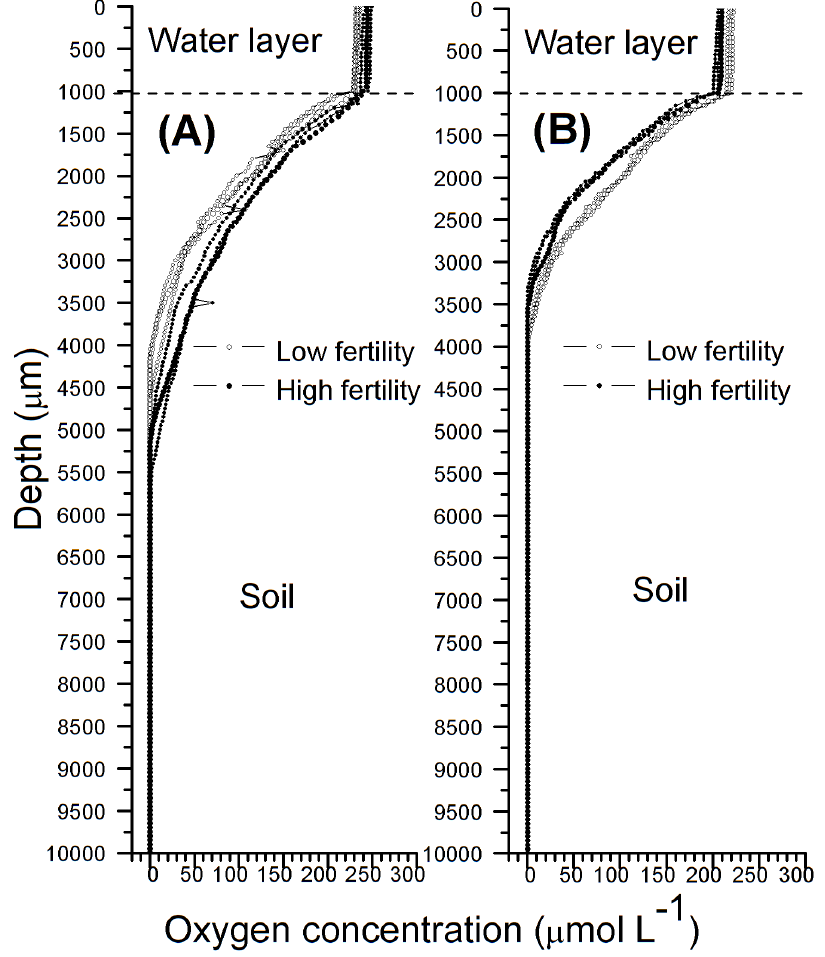
Figure 4. A representative graph showing oxygen profiles of (A) the rhizosphere soil (2 mm away from the root surface) and (B) the control (without rice plants) 50 d after germination in paddy soils with different fertility levels at 20 6 C. The oxygen microelectrode used was 20–30 m m in diameter (OXY25, Unisense, Aarhus, Denmark [31]). Three rhizoboxes for each treatment were used in the in situ measurements, and the oxygen concentration profile was determined in the right and left compartments of each rhizobox. All measurements were conducted in the centre of the range marked by a 2-mm distance from the nylon nets in the low- and high-fertility soils with and without the rice plant treatments. Hence, the measurements were repeated six times in each treatment. Three results (measured in the right compartment) are shown, and each curve shows one individual soil oxygen profile. doi:10.1371/journal.pone.0109161.g004 PLOS ONE |